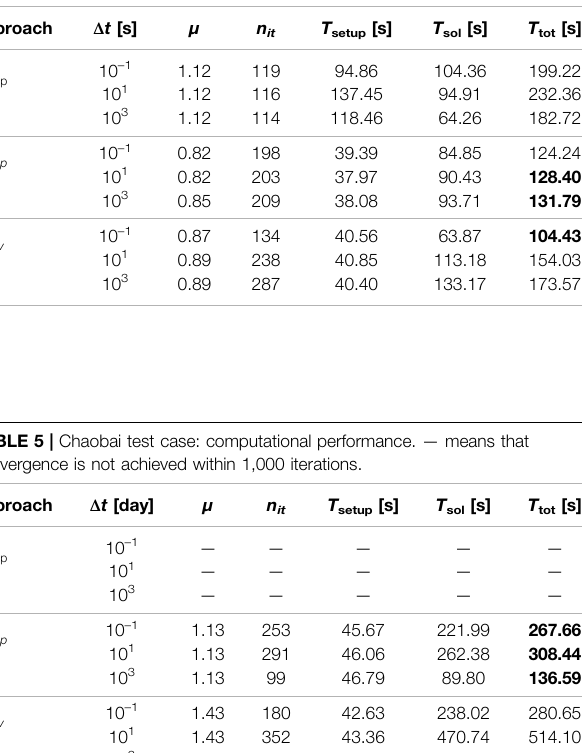
TABLE 4 | SPE10-35 test case: computational performance.